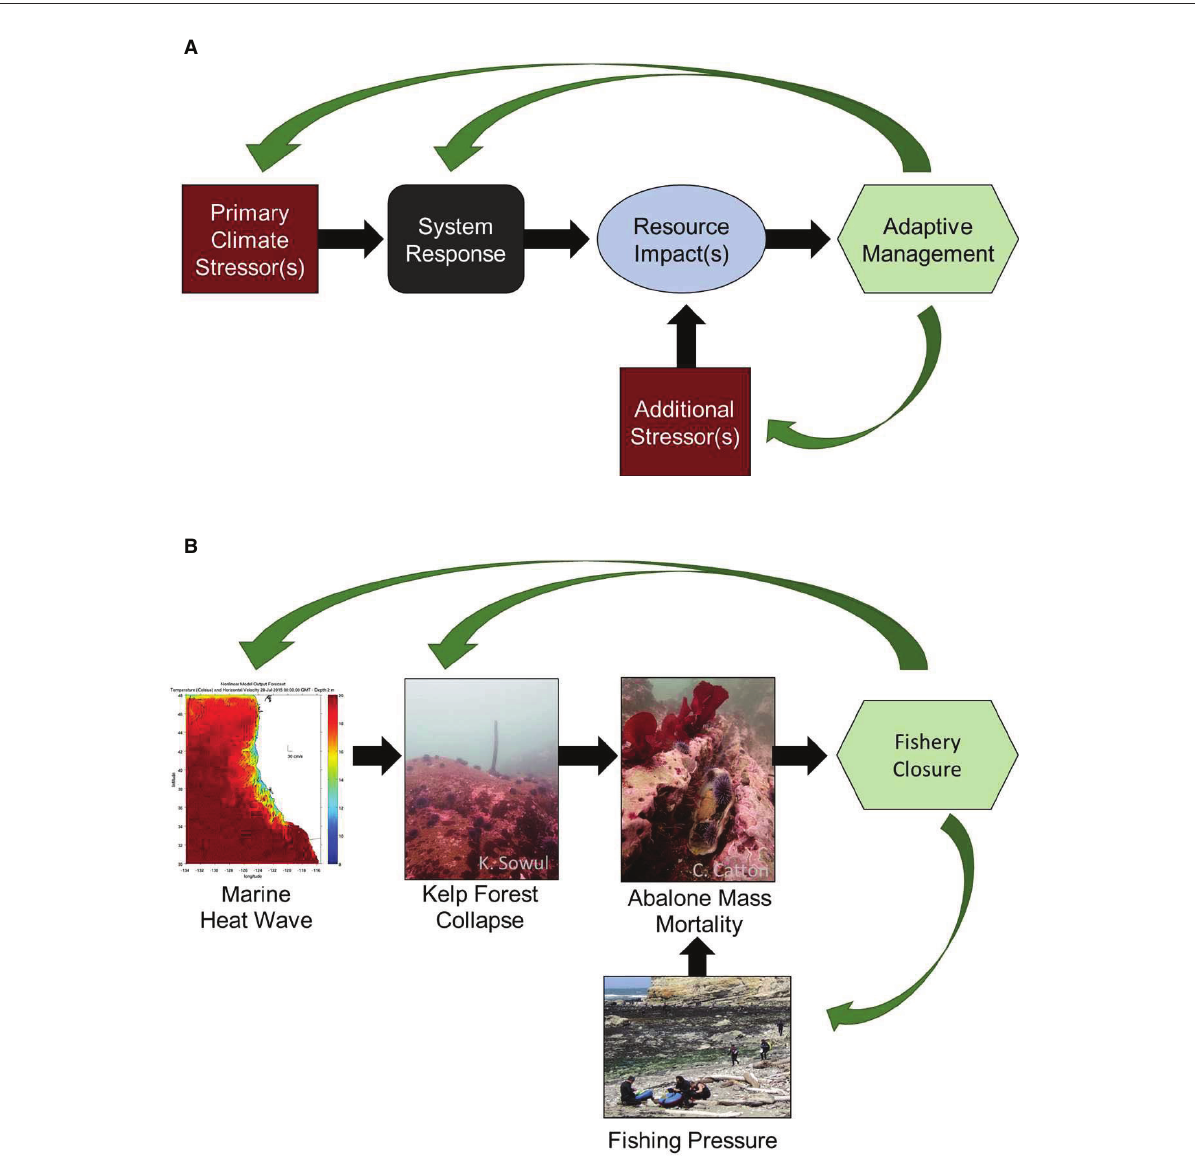
FIGURE1 (A) Conceptual Framework for investigating cascading risks of climate change. (B) Conceptual Framework: Abalone case study (with details of “Resource Impact” and “Additional Stressors” explored in the